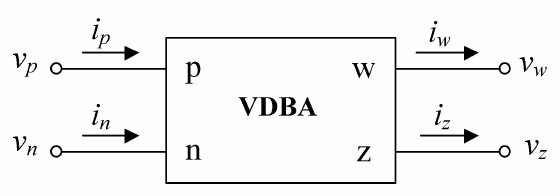
Figure 1. Electrical symbol of the